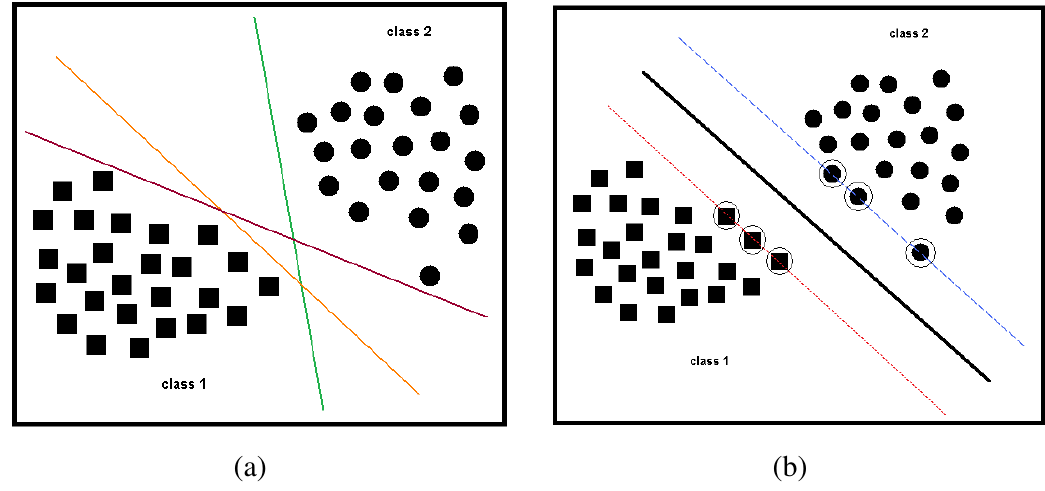
Figure 12. (a) Three different hyperplanes separating two classes; (b) SVM hyperplane (solid line), its margins (dotted and dashed lines), and the support vectors (circled solid squares and